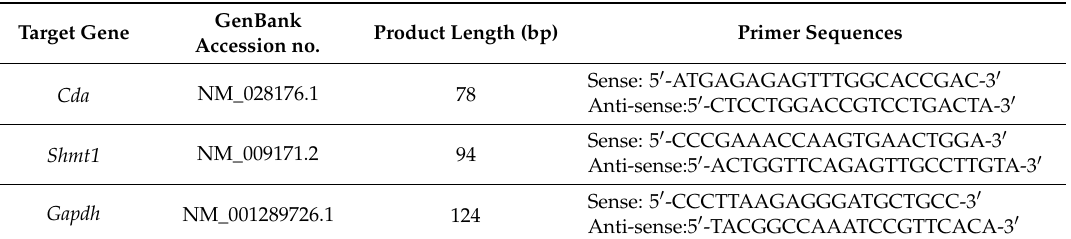
Table 1. Primers for real-time